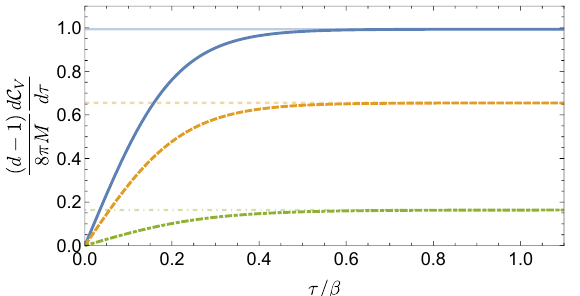
Figure 13 . The time derivative of complexity with d = 4, k = 0 with non-zero chemical potential, by (cid:12)xing the parameters in eq. (4.29). The various curves correspond to: (cid:23) = 0 : 1 in blue (solid), (cid:23) = 1 in orange (dashed) and (cid:23) = 5 in green (dot-dashed). Curves are independent of TR in eq. (4.12) as expected for the planar geometry. Late time limits are obtained from eqs. (3.17), (3.19) and are indicated by horizontal lines of the appropriate